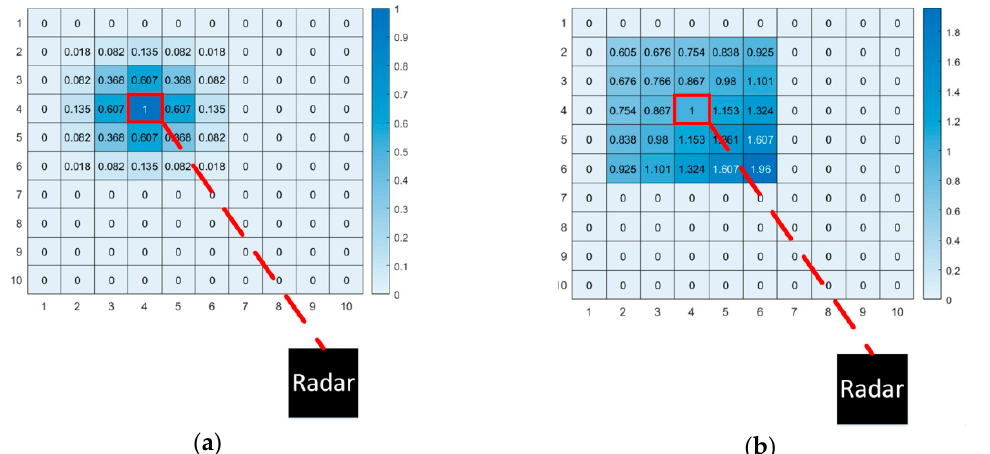
Figure 8. Two rasterized lookup tables. The black squares are radars, and the red squares represent the targets observed by the radar. ( a ) Rasterized lookup table based on occupancy probability. The number in the grid represents the probability of this grid being occupied. ( b ) The lookup table was based on the echo power, and the number in the grid represents the echo power of this grid.